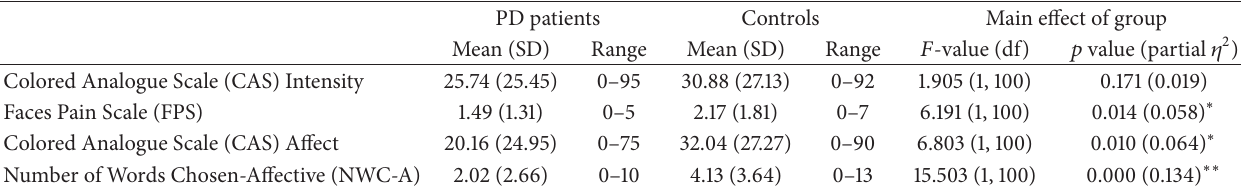
Table 3: Pain scores in PD patients and controls. SD: standard deviation, ∗ 𝑝 < 0.05 , and ∗∗ 𝑝 < 0.001